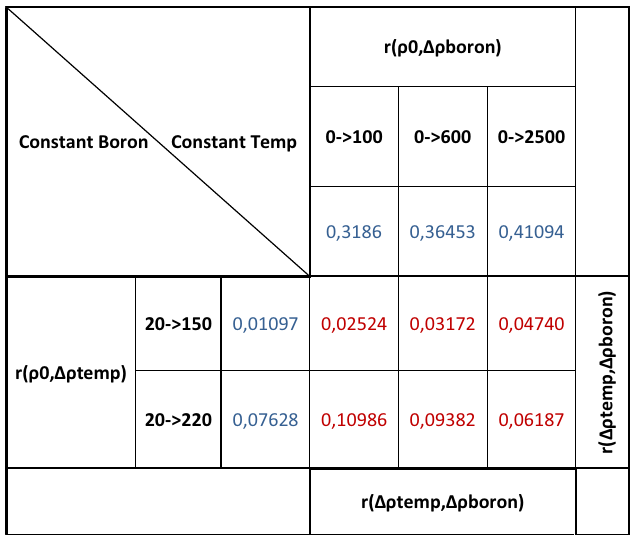
Table 6. Pearson coef fi cients calculated between reactiv- ity coef fi cients or reference reactivity and reactivity coef fi